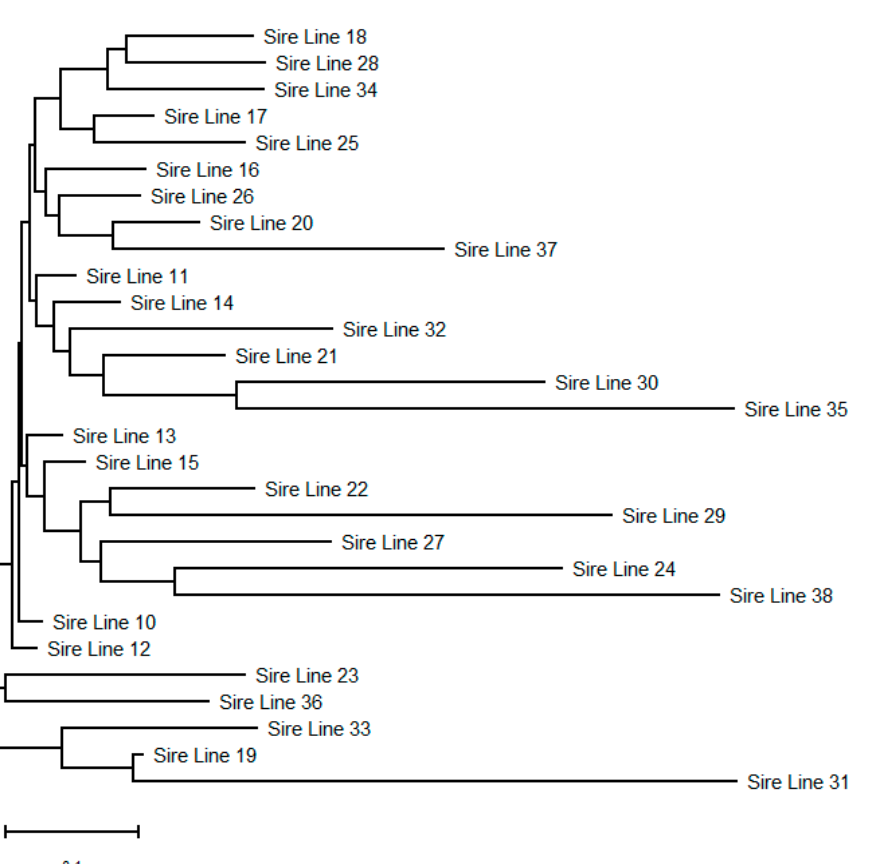
Figure 4. Unrooted tree showing relationships among 29 sire-lines of the Croatian Posavina horse. An FCA scatter plot was constructed including all animals and loci to summarize the individual relationships, with two principal factors explaining 5.97% of the total variation (not shown). With the exception of five individuals that were dislocated from the rest of the population, the other individuals were evenly scattered along the two dimensions of the FCA and the lines overlapped with no indication of grouping. The results show no clear separation and indicate that the CPH stallions studied are genetically heterogeneous.